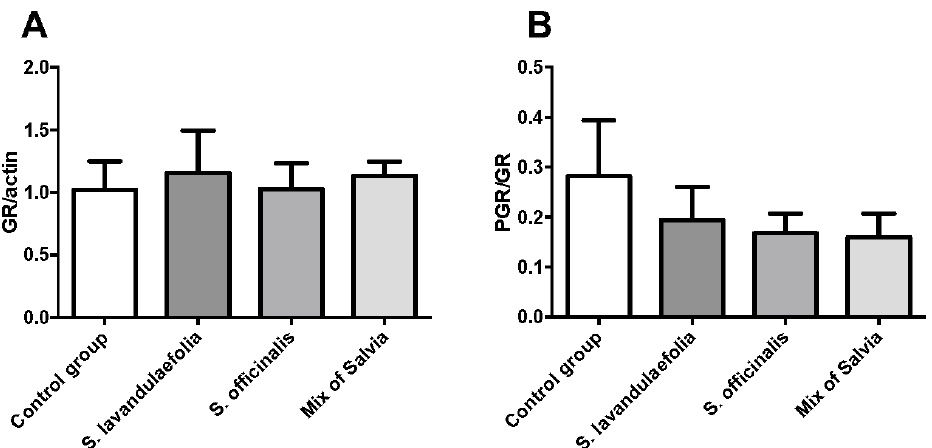
Figure 7. Chronic mix of Salvia supplementation did not impact glucocorticoid receptor (GR) and its phosphorylated form (P-GR) protein expression. The protein expression of GR ( A ) and P-GR ( B ) compared to actin was evaluated by Western blot (n = 6 per group).